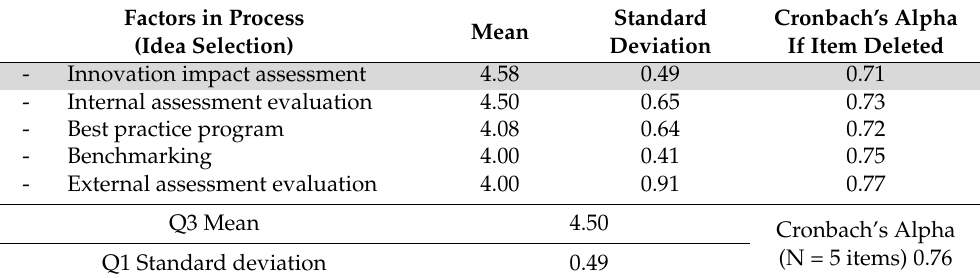
Table 5. Calculation of Q3 mean and Q1 standard deviation of idea selection process indicator